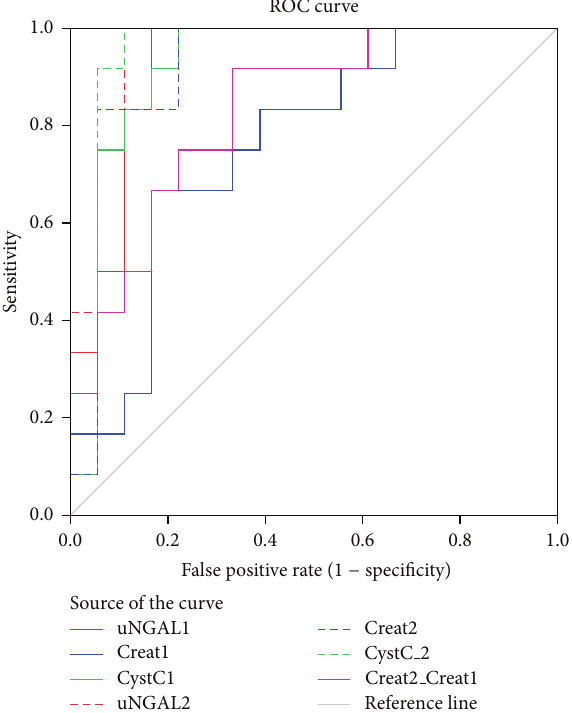
Figure 3: Receiver-operating characteristic curves for uNGAL, serum creatinine and changes in serum creatinine, and serum cystatin C measured at posttransplant days 1 and 2 for predicting delayed graft function. Abbreviations: uNGAL: urinary neutrophil gelatinase associated lipocalin; Creat: serum creatinine; Cyst: serum CystatinC;Creat2-Creat1:creatininereductionratebetweenthefirst and the second